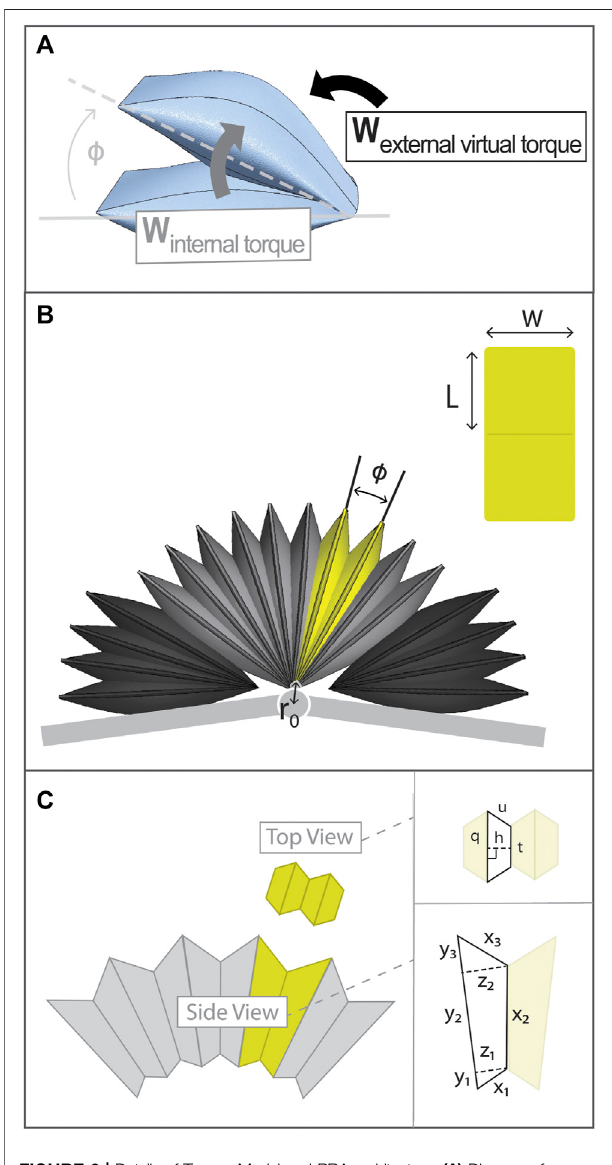
FIGURE 2 | Details of Torque Model and PRA architecture. (A) Diagram of internalworkandexternalvirtualworkofPRAwhicharesetinequilibriumtodetermine torqueoutputofPRA. (B) Entireactuationassembly withasinglePRAhighlightedin yellowandaviewofPRAlaid fl attoshowitsdimensionlabels. (C) PRAvolume is approximated using geometric shapes, with dimensions labels as